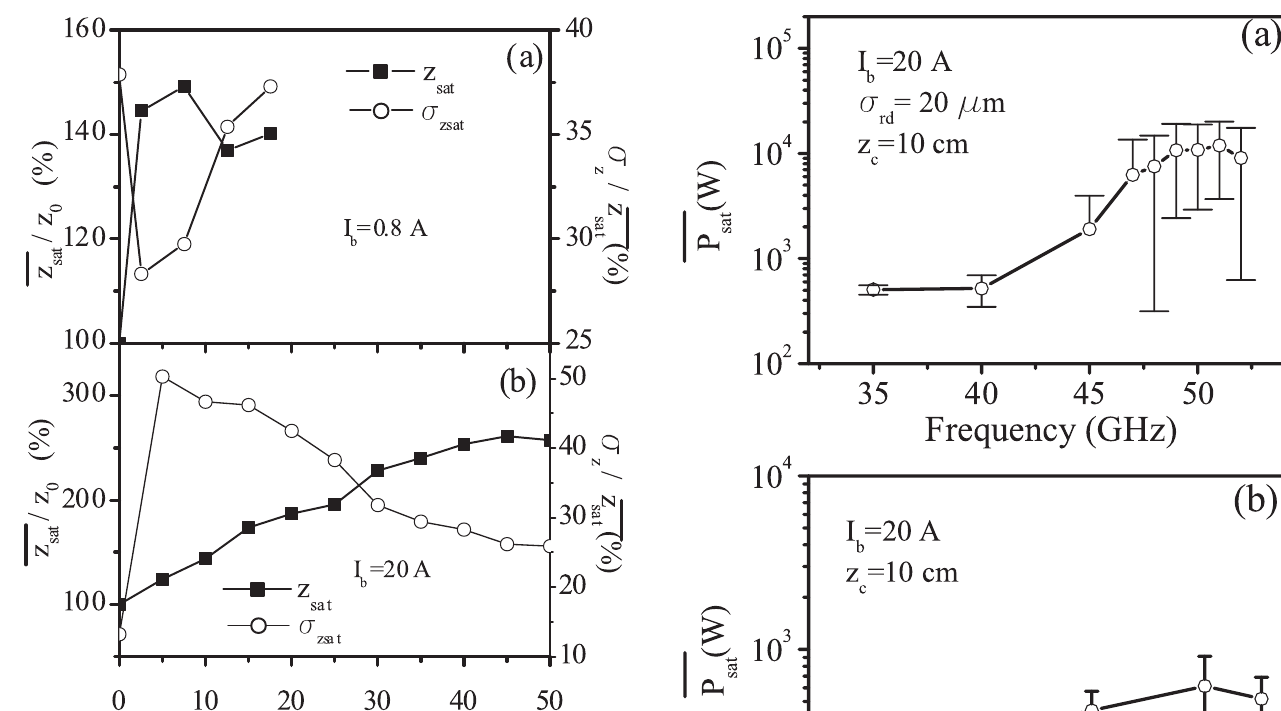
FIG. 5. Normalized distance to saturation ( z malized standard deviation of z standard deviation of the liner fluctuations (cid:6) current of 0.8 A (a) and a strong pump current of 20 A (b), at a frequency of 50.2 GHz. The lines are for